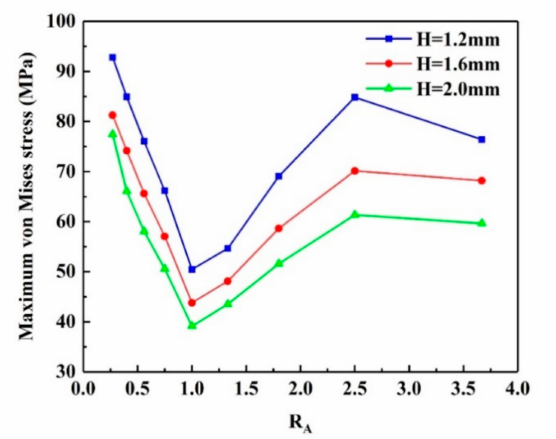
Figure 12. Change of the maximum von Mises stress with cross-sectional area ratio of the cold side to hot side of the leg for di ff erent